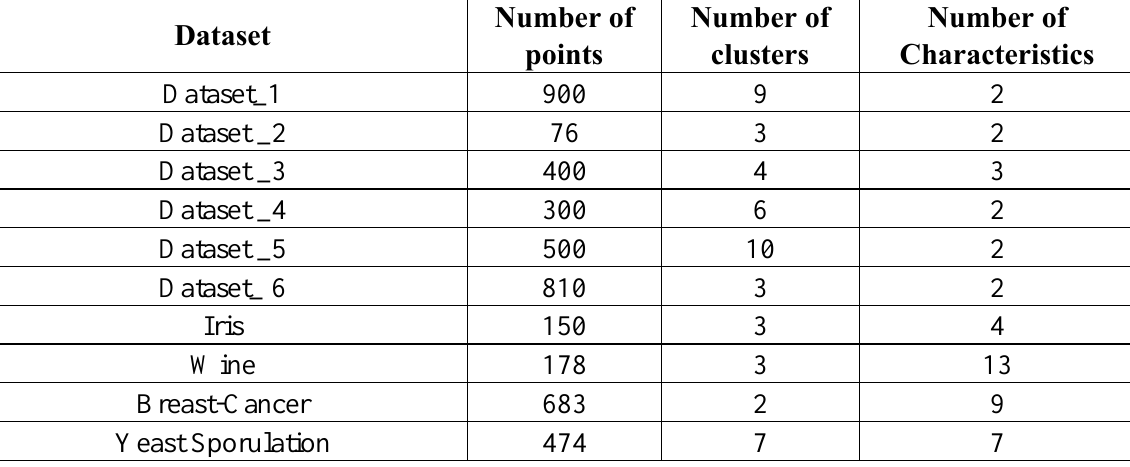
Table 1. Details of the datasets